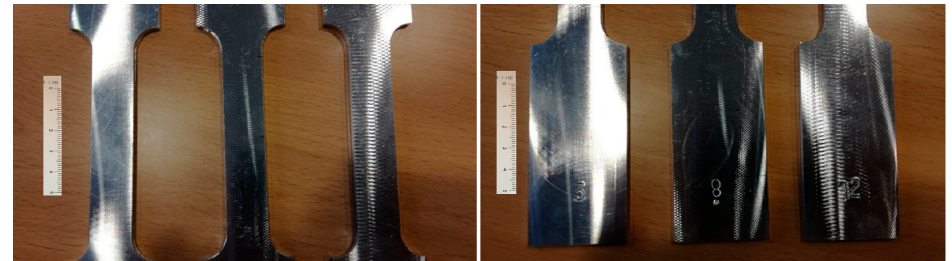
Figure 2. Machined samples from batches 1, 2, and 3 (scale bar in mm).